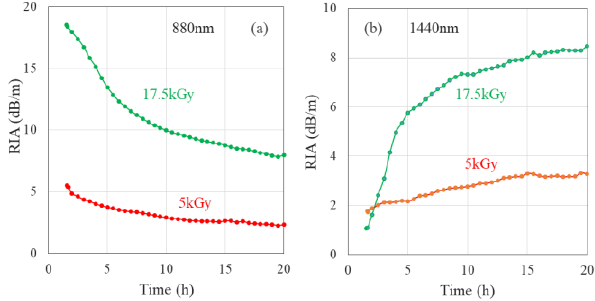
Fig. 7. RIA time evolution for 5 kGy and 17.5 kGy irradiation doses at 880 nm (a) and 1440 nm (b) wavelengths. The time is counted from the end of the